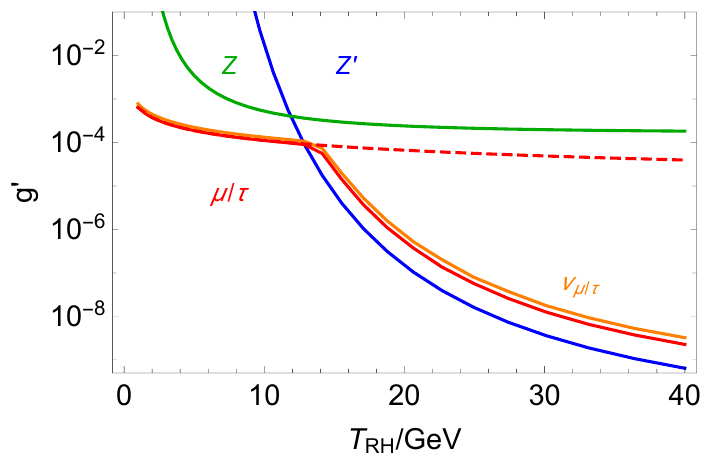
Figure 6 . Value of the gauge coupling g 0 needed to achieve the correct relic abundance of m X = 1 GeV dark matter from individual channels in the L µ − L τ model for q X = q l = 1 and m Z 0 = 500 GeV. Solid curves represent the full calculation, the red dashed curve is the EFT (non-resonant) result for the muons and taus, and the blue curve denotes the contribution from Z 0 decays. The Z decay contribution (green curve) is suppressed due to kinetic mixing only being induced at the